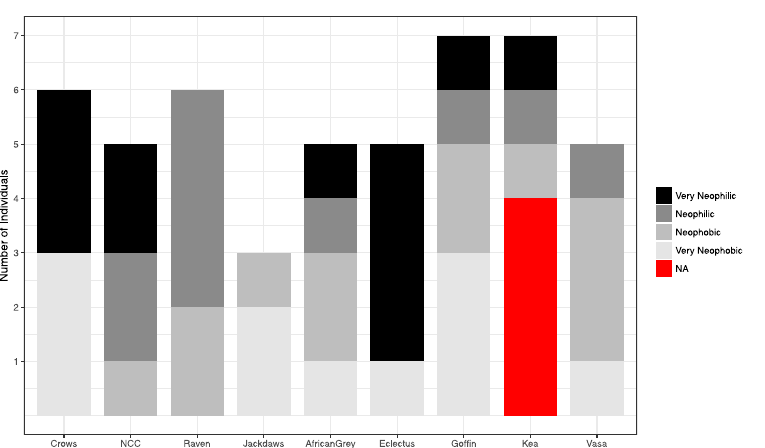
Figure 5. Number of individuals per species participating in the task. Shading indicates quartile latencies to respond to either stimulus in the first trial of the task after the touchscreen has been associated with a food reward: Black represents very fast approaching individuals (responding below 5.00 seconds); dark grey indicates fast approaching individuals (responses made between 5.00 and 21.97 seconds); slowly approaching individuals (responding within 21.97 and 66.87 seconds) were assigned medium grey; light grey shows very slowly approaching individuals (requiring more than 66.87 seconds to interact with the stimuli); the red bar indicates missing values of four individuals of kea for which no latencies are